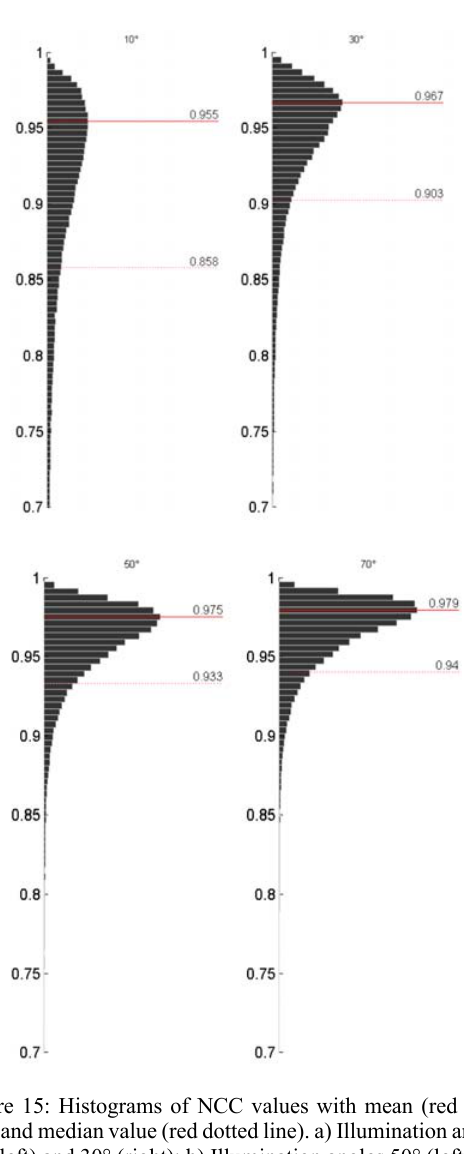
Figure 15: Histograms of NCC values with mean (red solid line) and median value (red dotted line). a) Illumination angles 10° (left) and 30° (right); b) Illumination angles 50° (left) and 70°